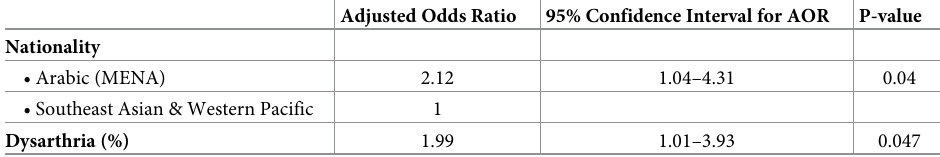
Table 2. Multiple logistic regression model to identify significantly associated independent variables for depres- sion (n = 233).